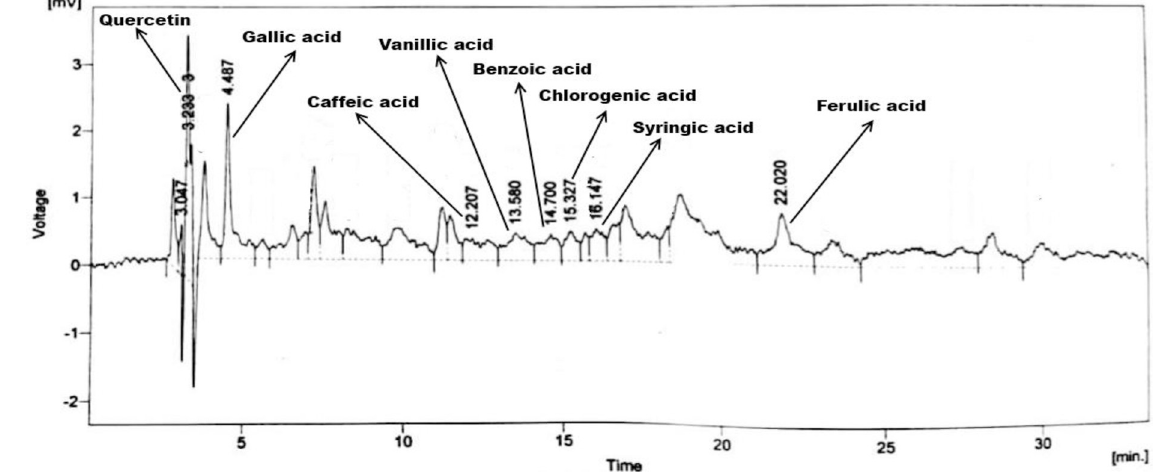
Fig 4. HPLC chromatogram of Euphorbia nivulia Buch.-Ham. aqueous extract.